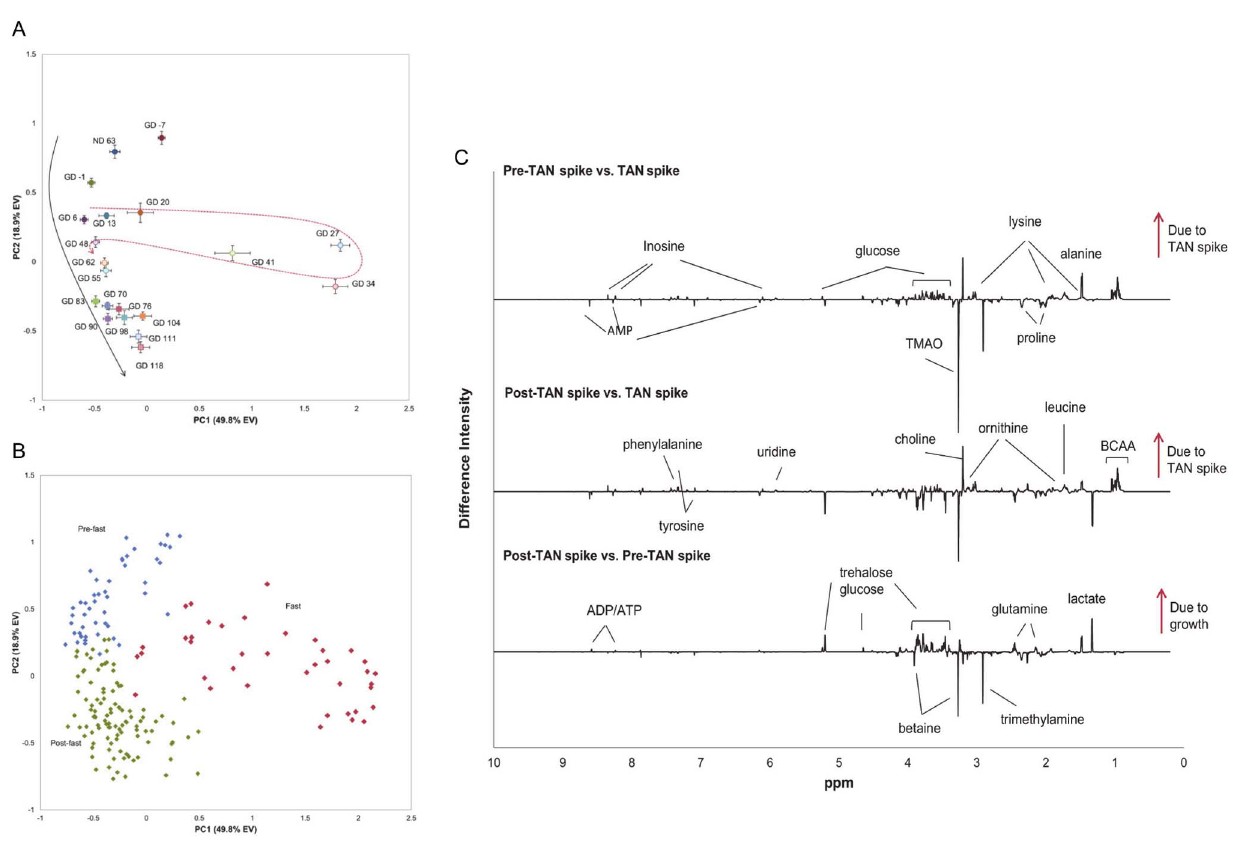
Figure 4. Raceway multivariate statistical analysis. PCA scores plot of muscle tissue from growout phase shrimp from the raceway system. (A) Each point represents the mean PC score for the sampling time point (ND: nursery phase day, GD: growout phase day) and the error bars represent the standard error of the mean. The solid black arrow suggests metabolic changes in relationship to growth, while the dashed red arrow denotes a deviation from and a return to ‘‘normal’’ growth. (B) Scores plot of individual growout phase shrimp colored by pre-fast (blue), fast (red), and post- fast (green). (C) SDS displaying metabolite changes in response to the fasting period and growth. The top spectrum compares pre-fast vs. fast shrimp, the middle spectrum represents fasted shrimp vs. post-fast shrimp, and the bottom spectrum displays metabolite changes from pre-fast vs. post-fast shrimp. Metabolites increasing as a result of the fast are positive in the top two spectra and metabolites increasing during growth are positive in the bottom spectrum. Not all significantly changing metabolites mentioned in the text are annotated